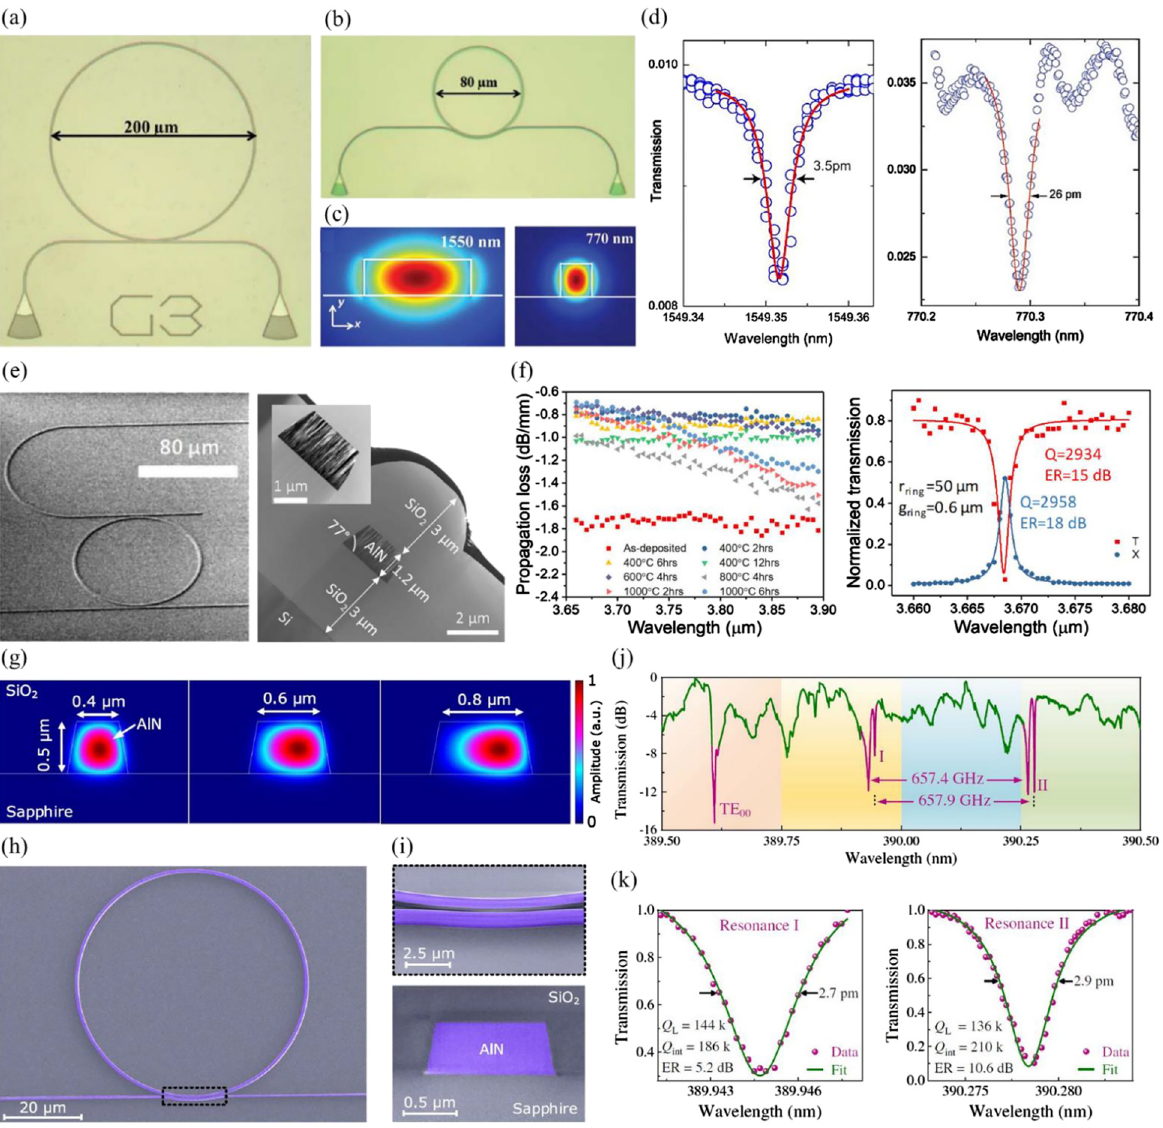
Figure 2: AlN-based integrated linear optical devices. (a) Microscopic image of fabricated microring resonator working at NIR. (b) Microscopic image of fabricated microring resonator working at visible. (c) Simulated fundamental TE mode within AlN waveguide cross section at 1550 nm (left panel) and 770 nm (right panel). (d) Zoom-in spectrumresponseofthemicroringresonatoraroundwavelengthof1550nm(leftpanel)and770nm(rightpanel).Thecorrespondingcavity Q aremeasuredtobe4.4 × 10 5 at1549nm,3 × 10 4 at770nm.(a) – (d)Adaptedwithpermissionfrom[82]©TheOpticalSociety.(e)Leftpanel:SEM image of patterned AlN microring resonator (without top cladding) designed for MIR wavelength range. Right panel: TEM image of fabricated AlNwaveguideforMIRworkingwavelength.Inset:zoom-inviewoftheAlNwaveguide. (e)is adaptedwithpermissionfrom[140]©TheOptical Society. (f) Left panel: waveguide propagation loss under different annealing conditions within the wavelength range of 3.66 – 3.9 μ m. Annealing process at 400 ° C for 4 h gives the lowest loss: 0.8 dB/mm, which is about half of the original loss. Right panel: spectrum responseofthemicroringresonatorafterannealingprocess,showing Q valueof3.0 × 10 3 andextinctionratio(ER)of18dB.(f)isadaptedwith permission from [90] © The Optical Society. (g) Simulated optical mode con fi ned by AlN microring resonator, with waveguide width variation from0.4to0.8 μ m.(h)False-coloredSEMimageofpatternedAlNwaveguideonsapphiresubstratewithouttopcladding.(i)Toppanel:zoom-in viewofwaveguidetomicroringcouplingregion.Bottompanel:waveguidefacetwithtopSiO 2 cladding.(j)Spectrumresponseoftwocascaded microrings with slightly different diameters. (k) Zoom-in view of spectrum response of resonance I (left panel) and resonance II (right panel). The highest intrinsic cavity Q can be obtained as 2.1 × 10 5 . (g) – (k) Adapted with permission from [84] © The Optical